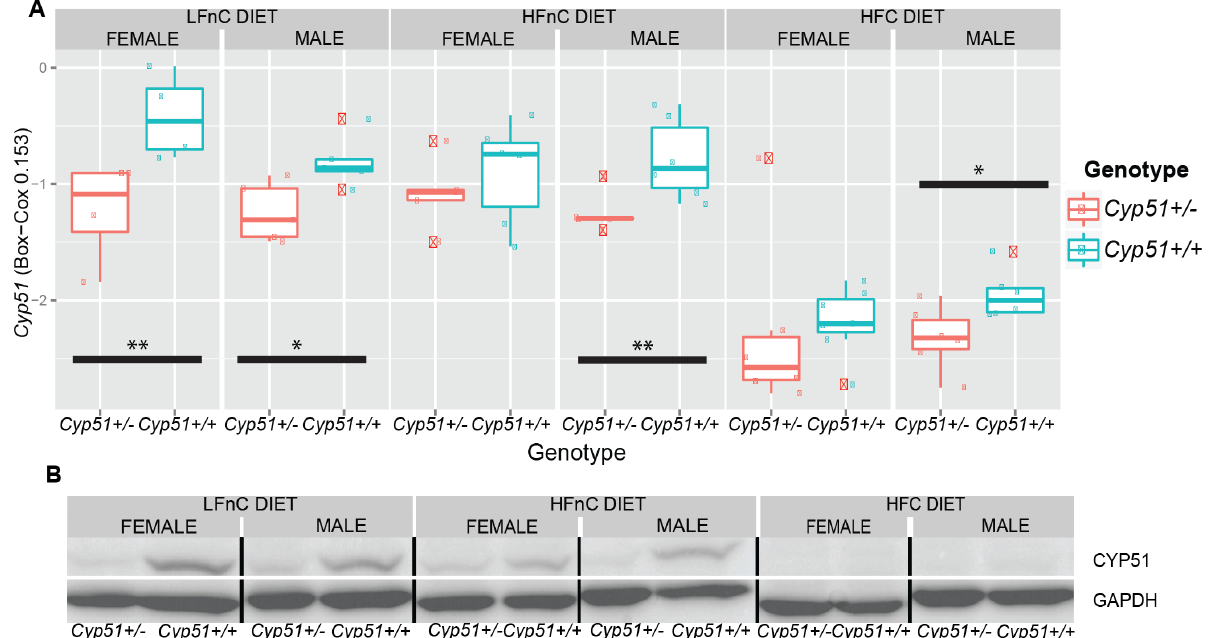
Figure 2. The expression of Cyp51 (A) on mRNA and (B) protein levels (western blot analysis).